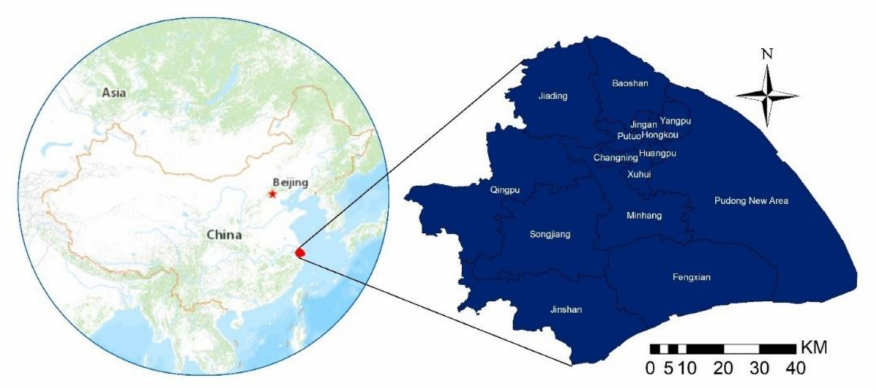
Figure 1. Shanghai (the study